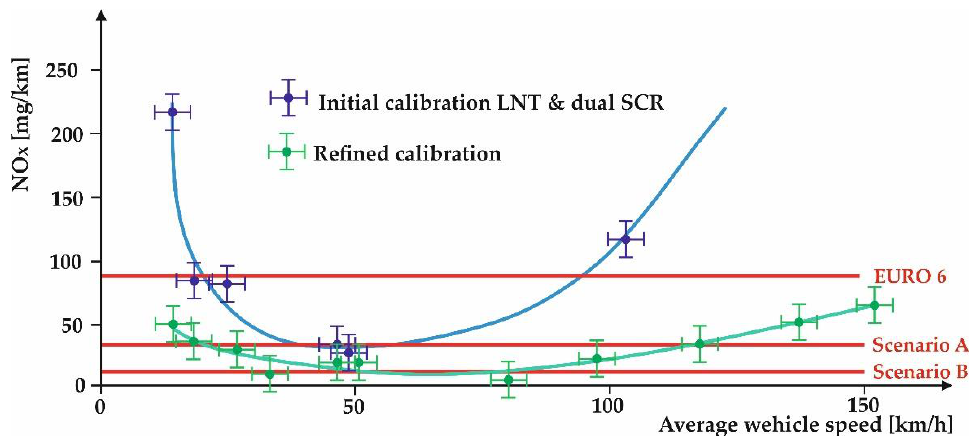
Figure 23. Predicted reductions in toxic exhaust emissions according to alternative scenarios projected for Euro 7, based on charts from [47].